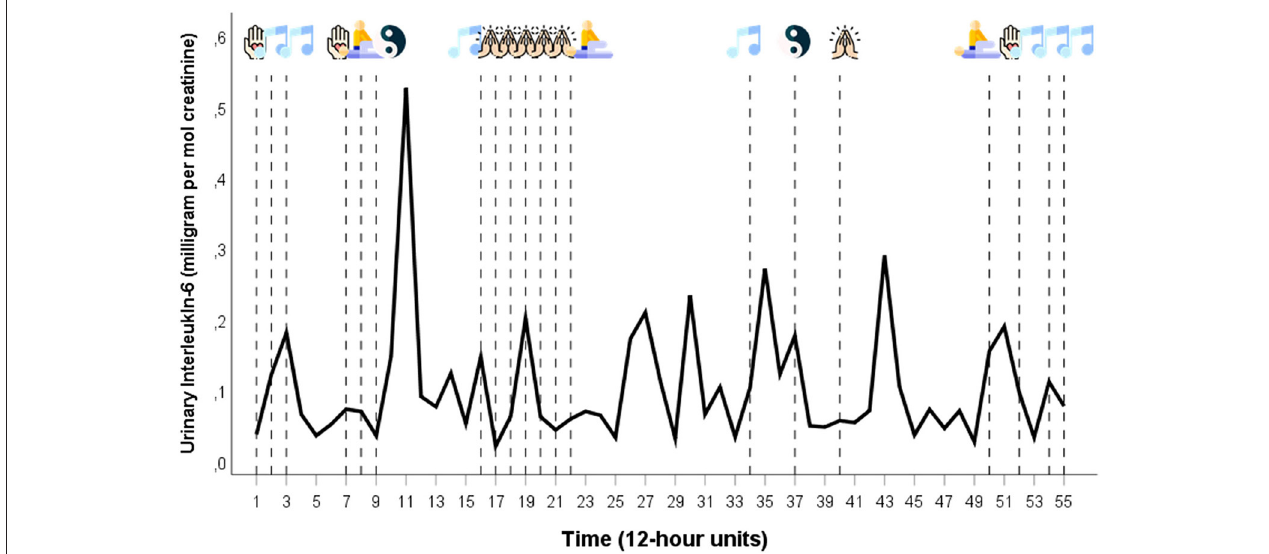
FIGURE 1 | Time series of urinary IL-6 per creatinine ratios together with CAM techniques in chronological order. The time series of urinary IL-6 covers a 28-day period during which the patient collected her full urine output in 12-hour intervals. The patient practiced CAM during 21 of the 55 12-hour units. Legend of the CAM icons: = Jin Shin Jyutsu; = Music; = Physiotherapy; = Tai